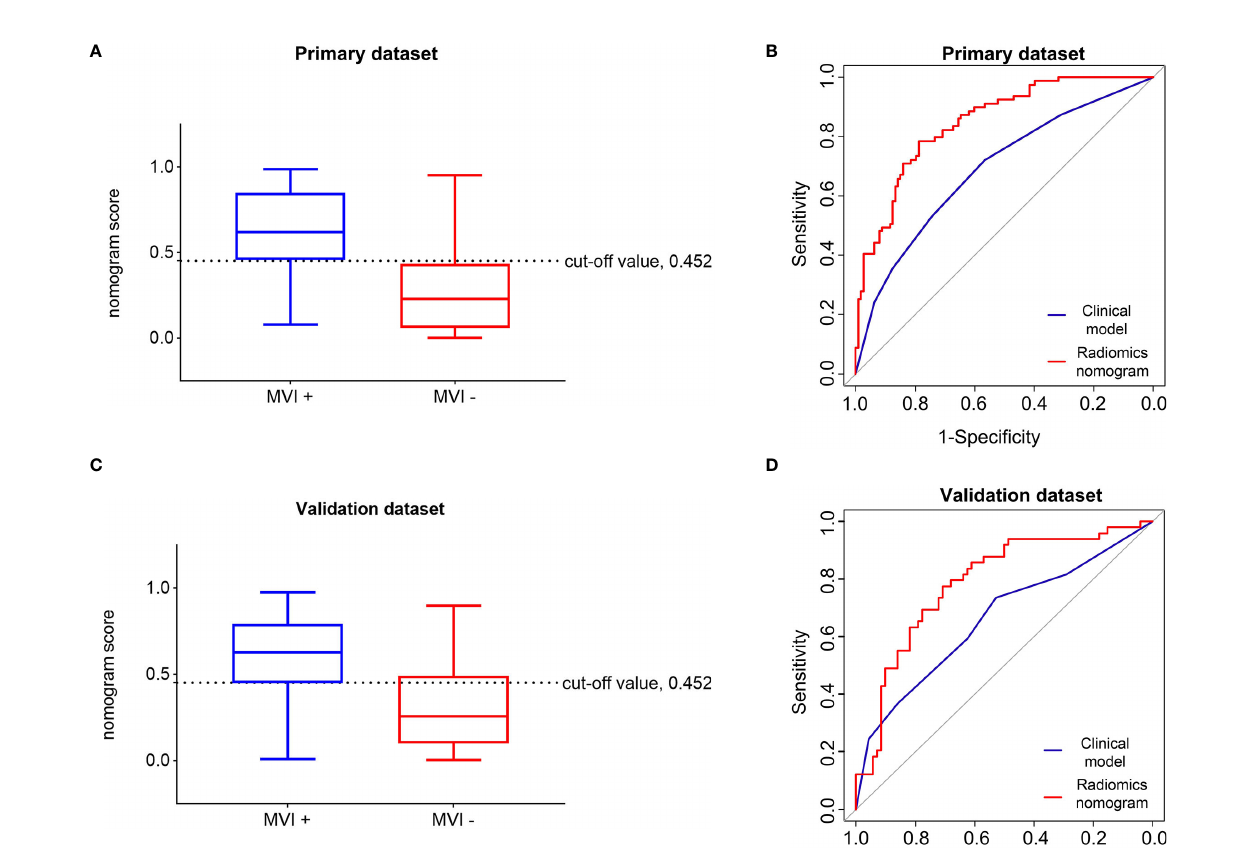
FIGURE 3 | Performance of the radiomics nomogram in predicting the MVI status of patients with hepatocellular carcinoma. Differential diagnosis of MVI+ and MVI − groups with the cut-off value of Nom-score of 0.452 in the primary (A) and validation (C) datasets. Receiver operating characteristic curves of the radiomics nomogram and clinical model in the primary (B) and validation (D) datasets. MVI+, patients with microvascular invasion; MVI − , patients without microvascular invasion.